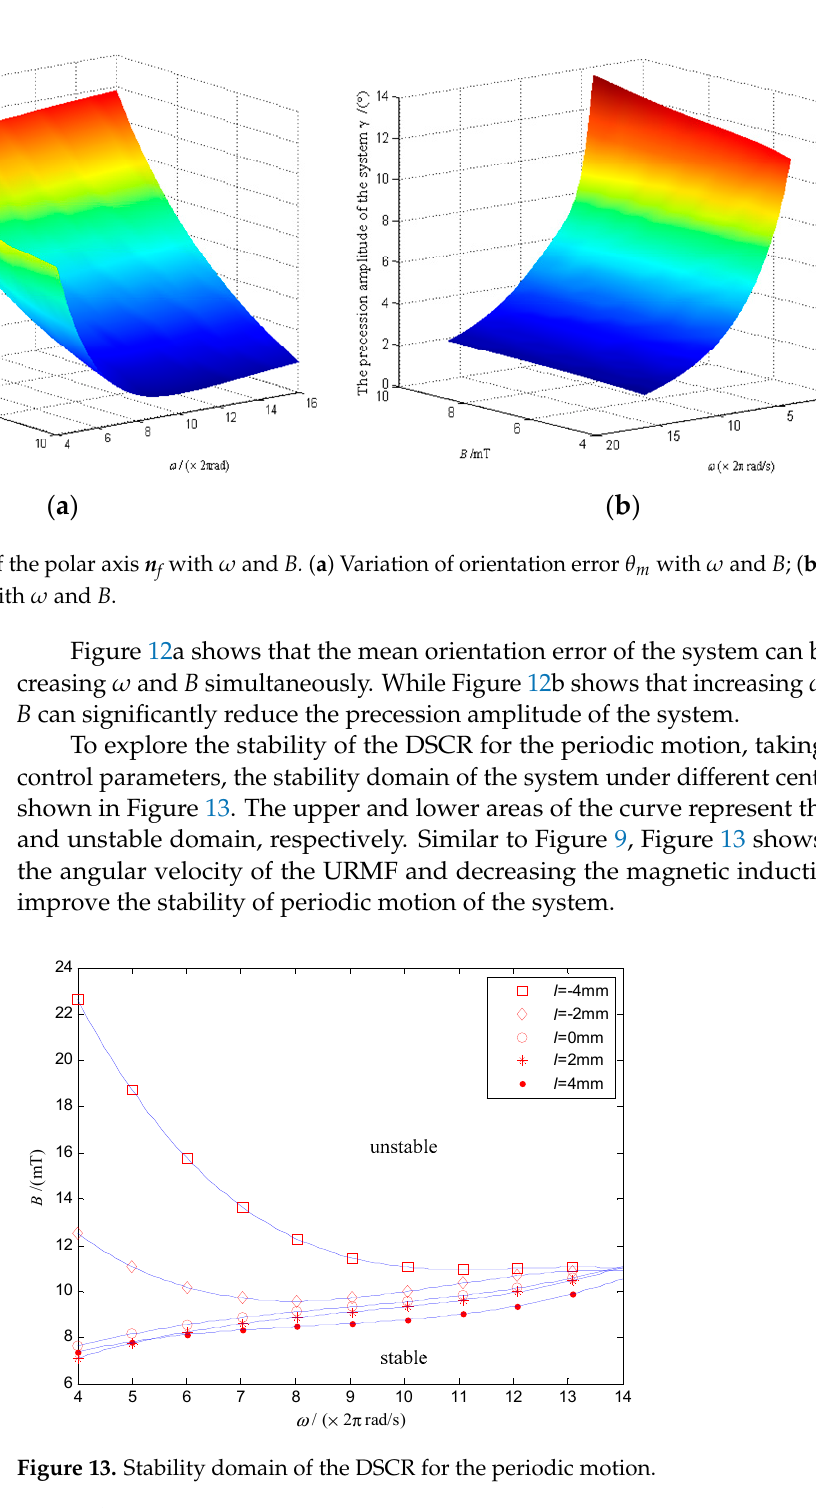
( b ) Figure 11. Variation law of the polar axis n f with the centroid deviation l . ( a ) Variation of orientation error θ m with cen- troid deviation l ; ( b ) Variation of precession amplitude γ with centroid deviation l . Figure 11 shows that when the centroid approaches the sphere center along the po- lar axis n f from below ( l < 0), the mean orientation error and the precession amplitude of the system are both decreasing. When the centroid coincides with the sphere center ( l = 0), the mean orientation error and the precession amplitude of the system are zeros. When the centroid deviates the sphere center along the polar axis n f from upwards ( l > 0), the mean orientation error and the precession amplitude of the system both keep in- creasing. At the same time, compared with the upward deviation of the centroid along the polar axis n f , when the centroid is deviated downward, the mean orientation error and the precession amplitude of the system are smaller. Therefore, in the assembly and manufacturing process, the centroid of the DSCR should be coincident with the sphere